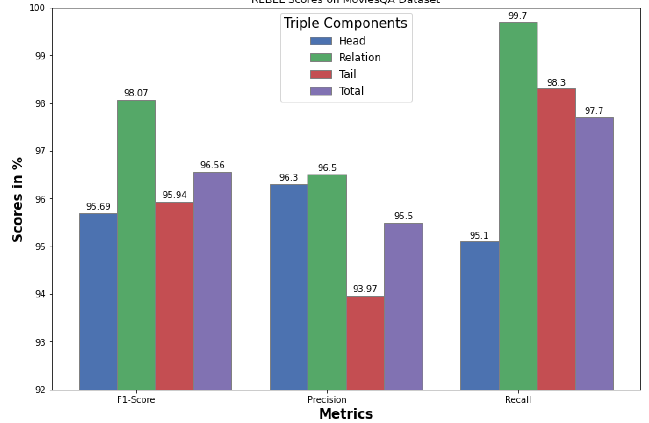
Figure 5. REBEL model validation score using 20% in the WikiMovies dataset, the scores show evaluation on each triple component: < subj, pred, obj > and an overall metric, in terms of Recall, Precision,